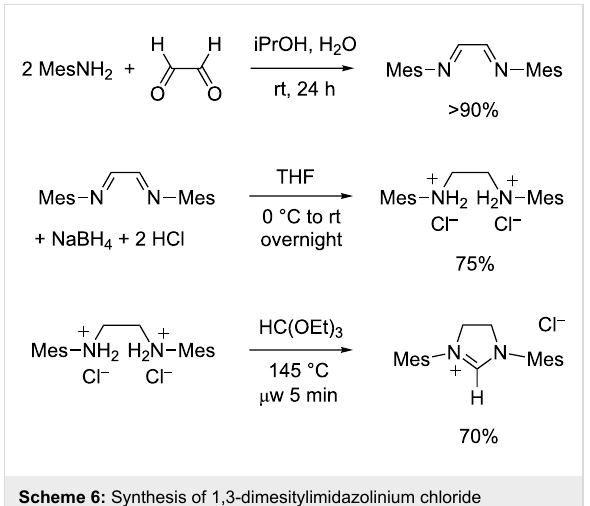
mental procedures for the preparation of imidazolinium